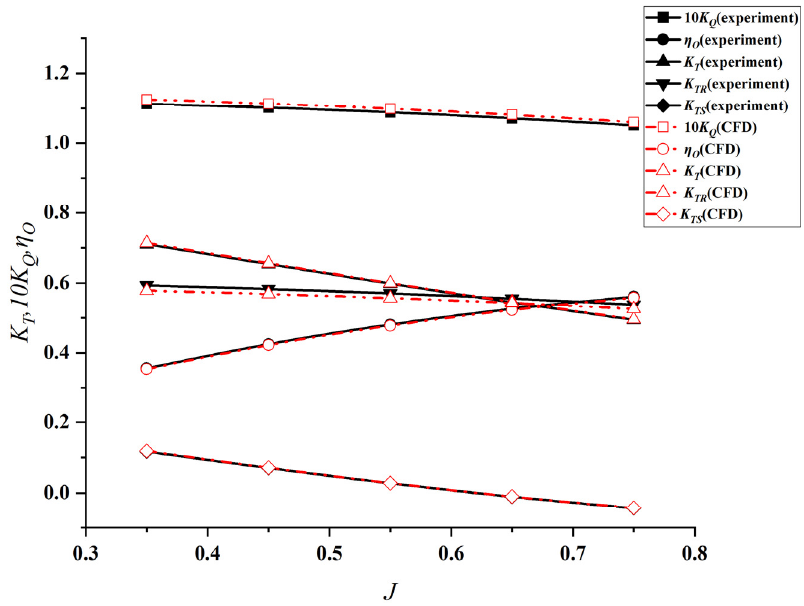
Figure 13. Comparison between the numerical and experimental results.